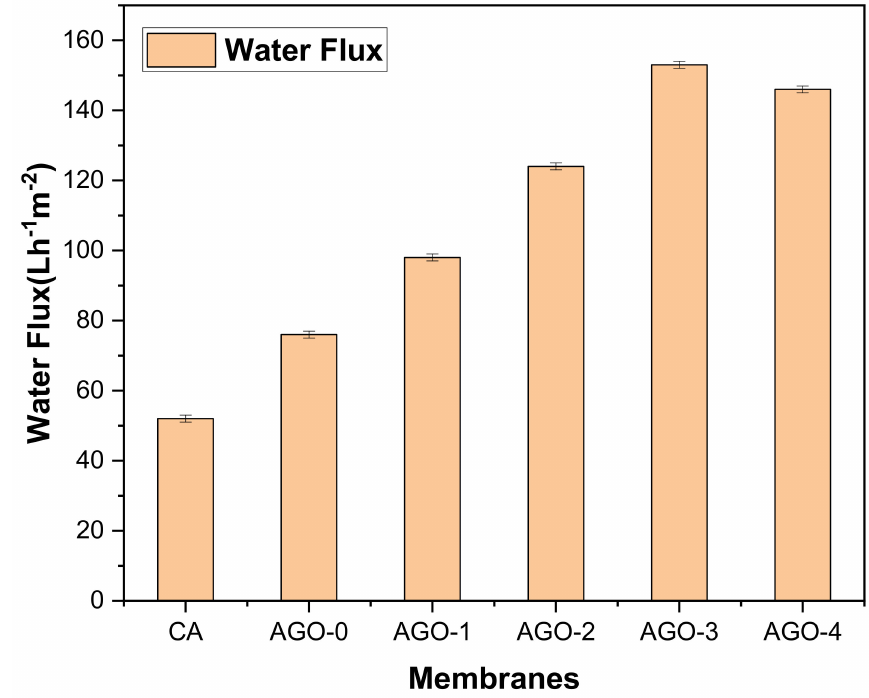
Figure 7. Water flux of AGO